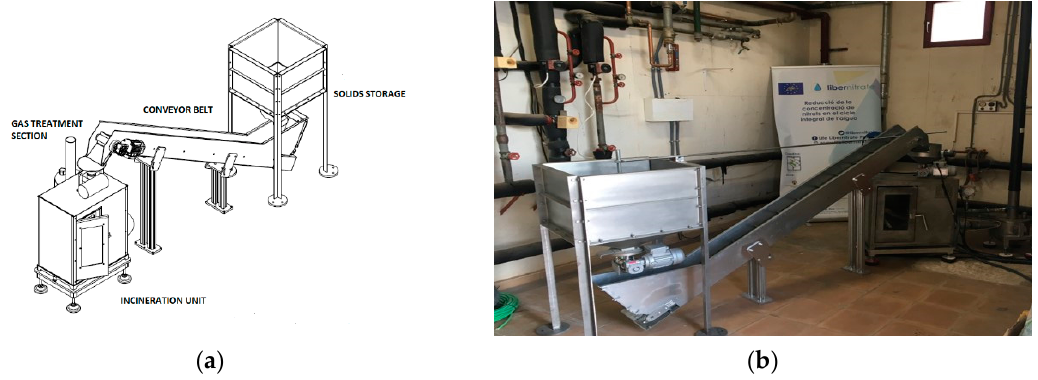
Figure 2. Design of the incineration plant ( a ) and final constructed plant ( b ).